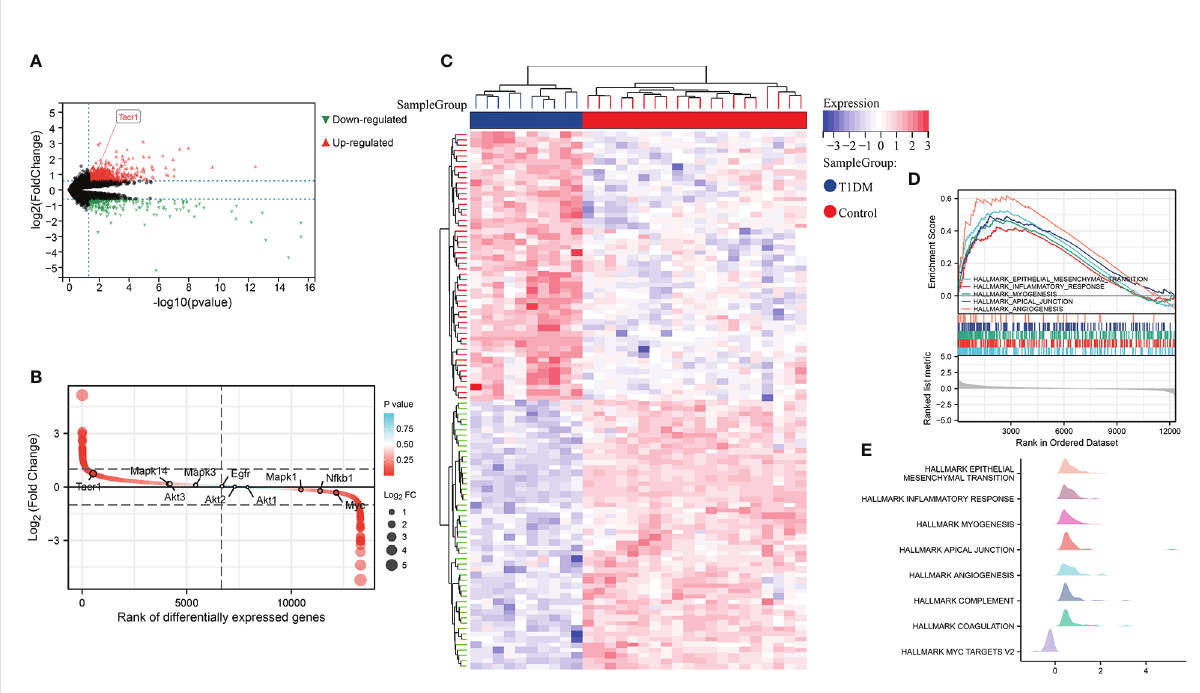
FIGURE 1 (A) Volcano plot of differential expression analysis in GSE37450 dataset. (B) Rank of differentially expressed genes in GSE37450 dataset. (C) Heatmap of differential expression analysis in GSE37450 dataset. (D) Enrichment score and the rank in ordered dataset of GSEA hallmark gene sets in GSE37450 dataset. (E) The distribution of gene expression in signi fi cant hallmark gene sets in GSE37450. X axis represents log2(Fold Change) of enriched